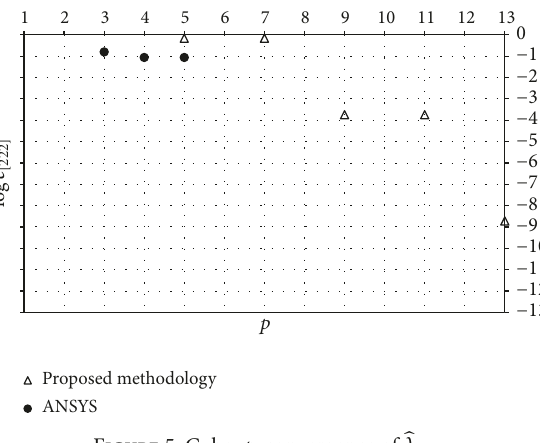
Figure 5: Cube: 𝑝 -convergence of